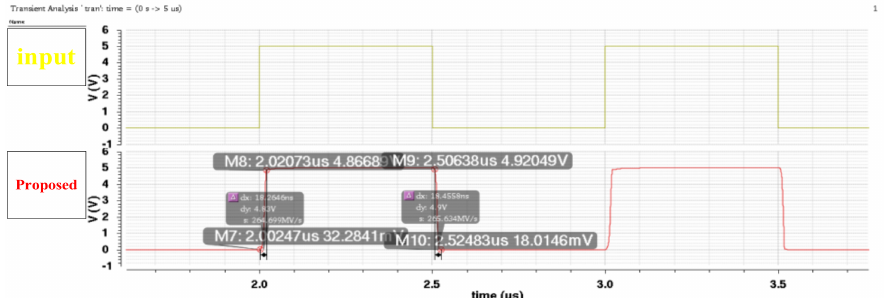
Figure 11. The transient simulation results of slew rate when the proposed circuit in closed-loop state is fed with a large-swing input.